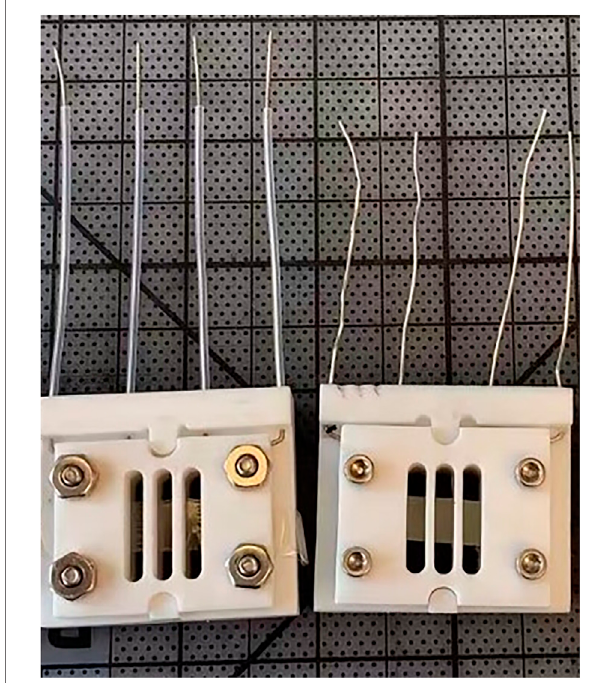
FIGURE 1 | Conductivity cells for in-plane ionic conductivity measurements using stand-alone membrane samples.